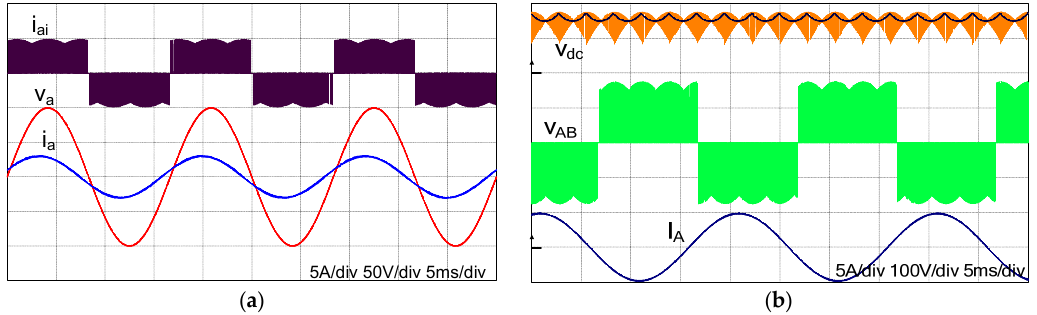
Figure 8. ( a ) Input waveforms; and ( b ) DC ‐ link voltage and output waveforms with the conventional method at m = 0.6 and f out = 50 Hz.